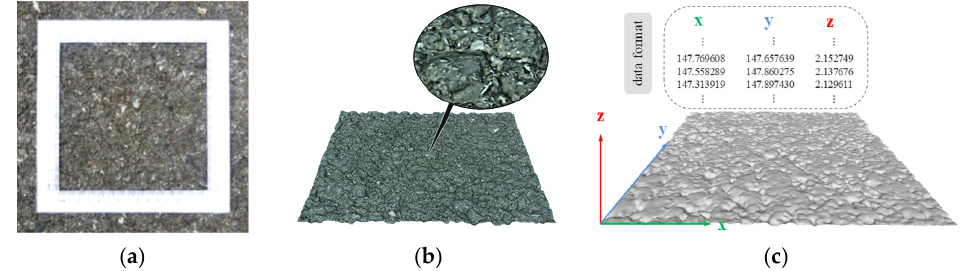
Figure 1. Acquisition of asphalt pavement texture information: ( a ) testing scope of pavement texture; ( b ) 3D digital pavement model; ( c ) 3D data of texture elevation.